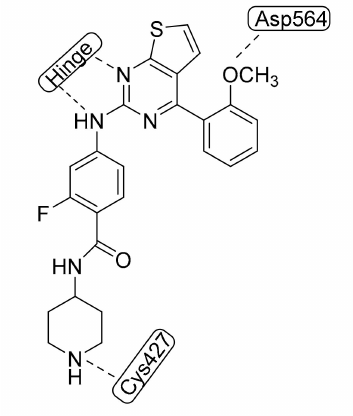
Figure 5. Chemical structure of the lead compound in the work by Zhao et al.